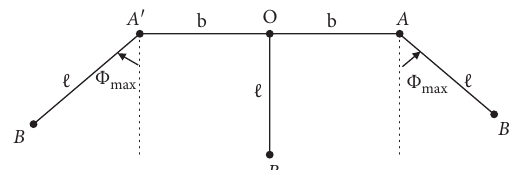
Figure 2: Description of the pendulum motion for case (i) in Section 4.1.